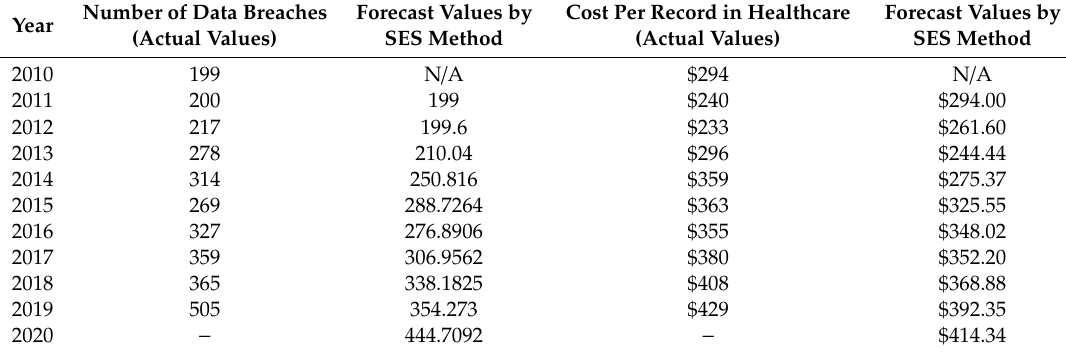
Table 9. Healthcare Data Breach Forecasting Using the SES